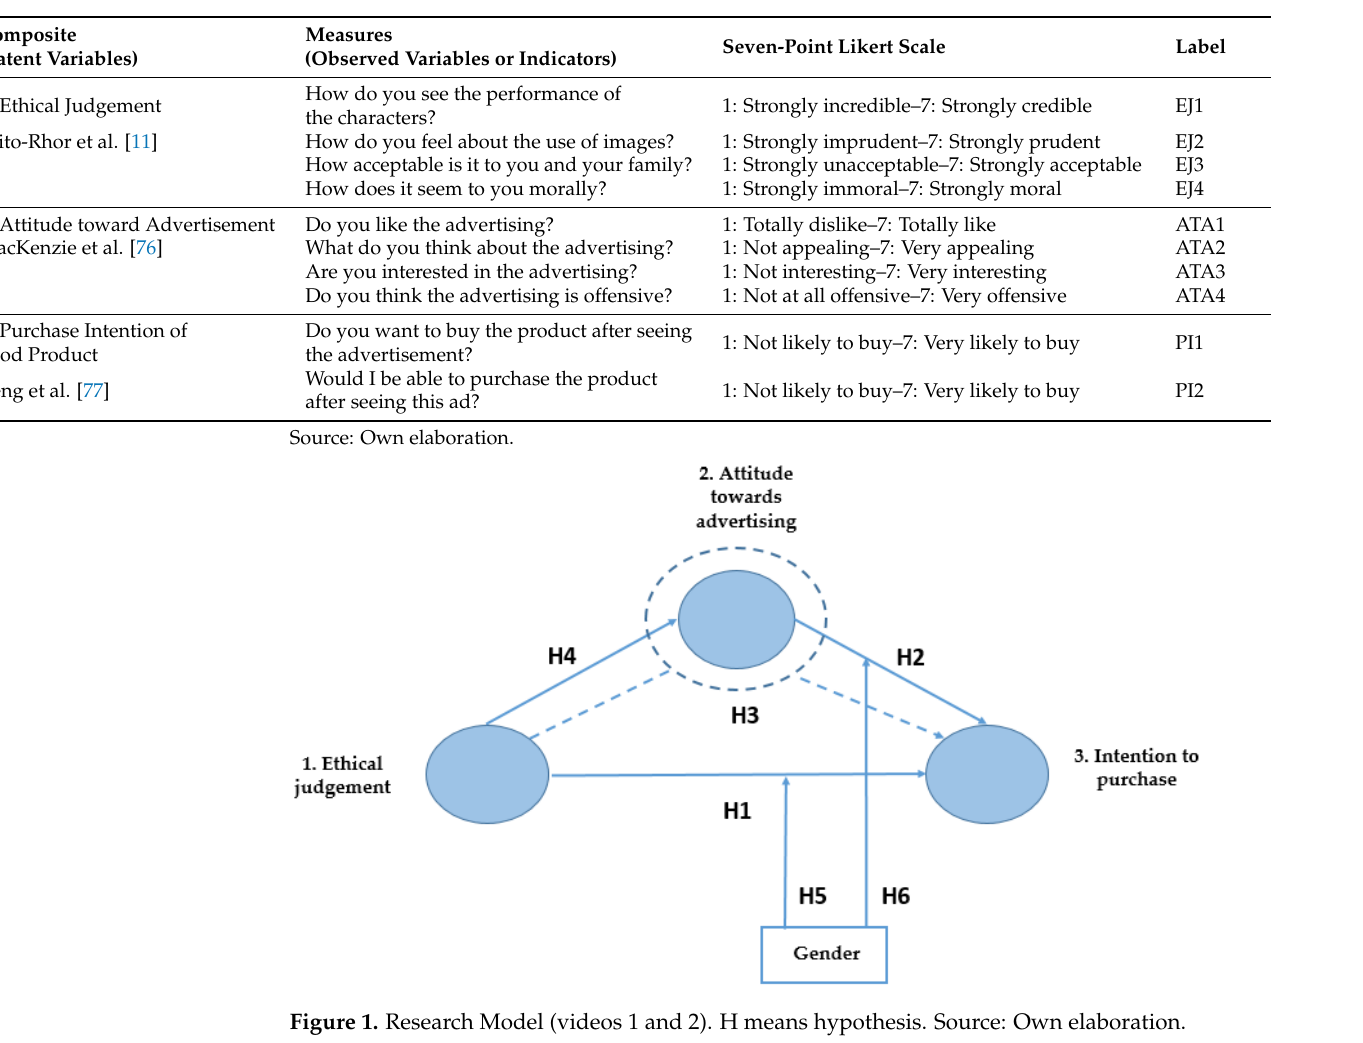
be severely non-normal as Kline established [80], p. 77. However, according to Hair-Jr. et al. [75], the general guide states that distributions showing skewness or kurtosis indexes that exceed the absolute value of 1 are considered non-normal.